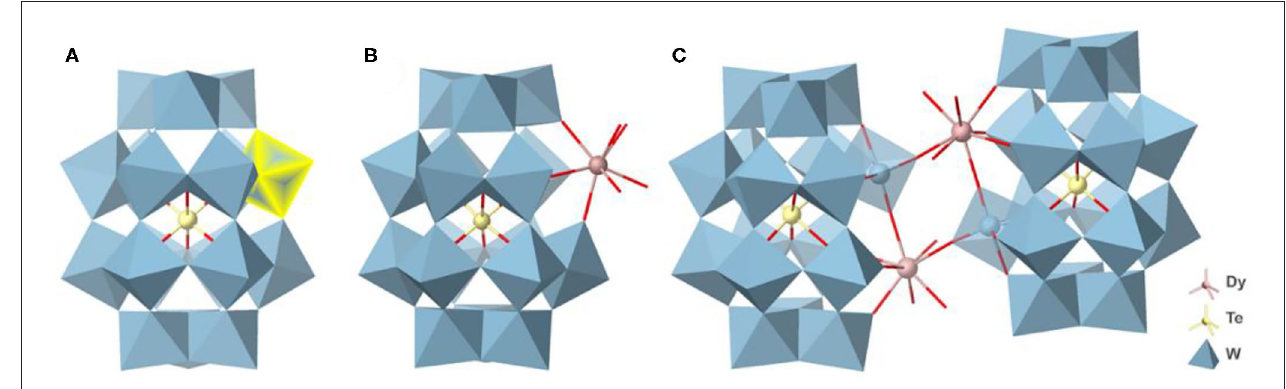
FIGURE 1 | The polyhedral and ball-and-stick view of (A) {TeW 18 O 62 }, (B) {DyTeW 17 }, and (C) {Dy 2 Te 2 W 34 }. The cations and the lattice H 2 O molecules are omitted for clarity.